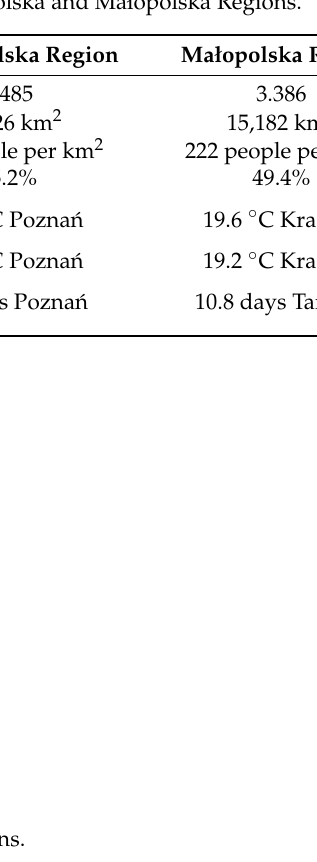
Table 1. Comparison of selected parameters for Wielkopolska and Małopolska Regions.